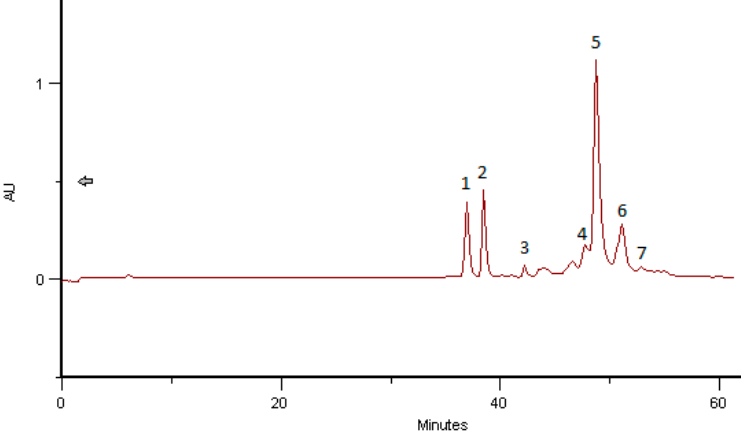
Figure 3. HPLC/DAD profile of BB India, June 2016 corresponding to 98% of Brassica napus L. (rape) pollen as taxon origin. Compounds 1 and 2 are Kaempferol-3- O -derivatives and compounds 3 – 7 are Hydroxycinnamic acids derivatives (data in line with Campos and Markham, 2007 [34]).